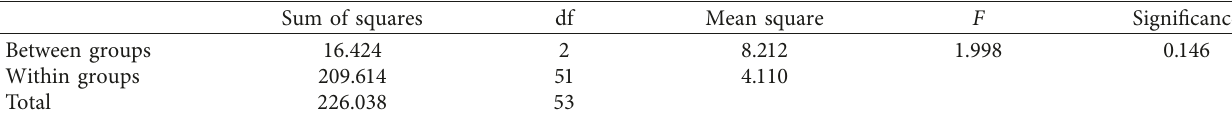
Table 5: One-way ANOVA for the pretest